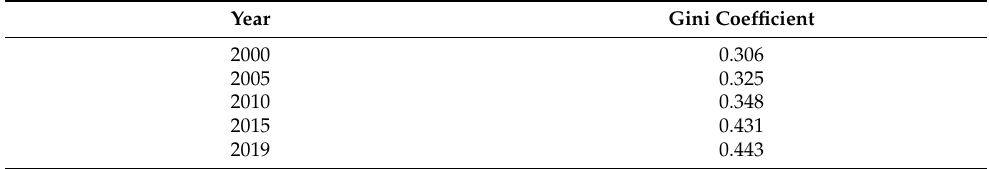
Table 12. The Gini coefficient of the ratio of residential land to industrial land in Shanghai (2000–2019).